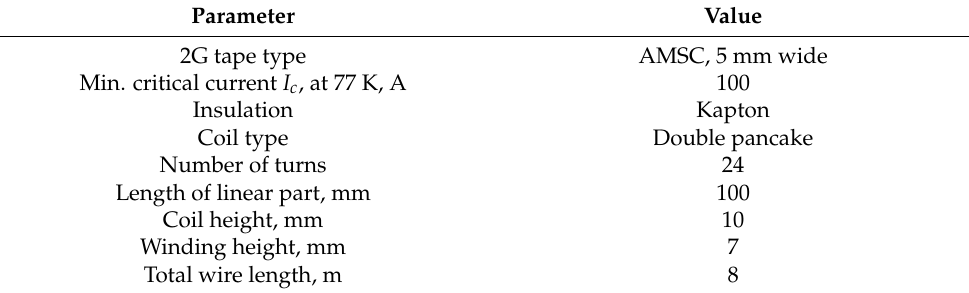
Table 1. Parameters of the coil.